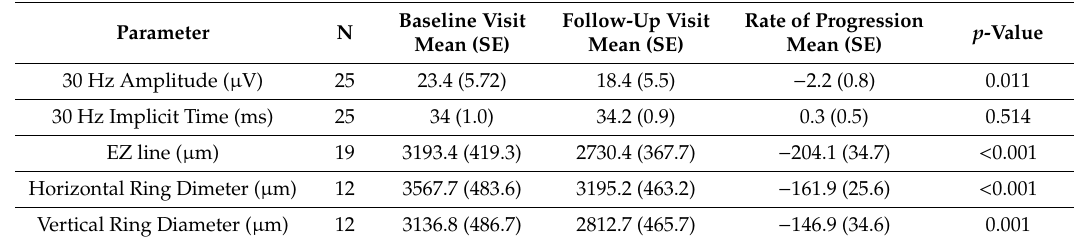
Table 5. Rates of disease progression per year with respect to electroretinogram (ERG) and structural imaging parameters. Data are summarized as mean and standard deviation